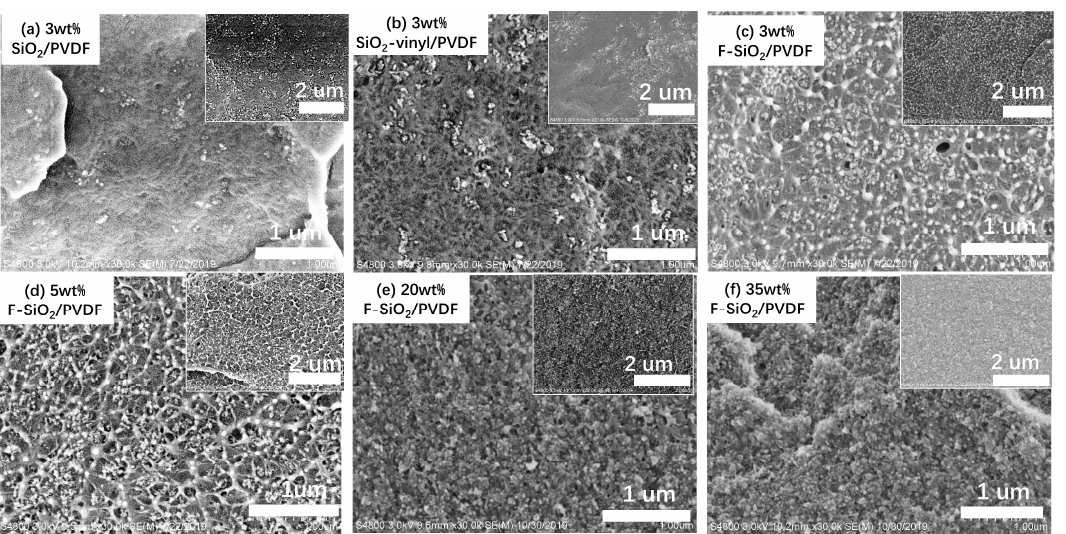
2 , ( b ) SiO 2 -vinyl,